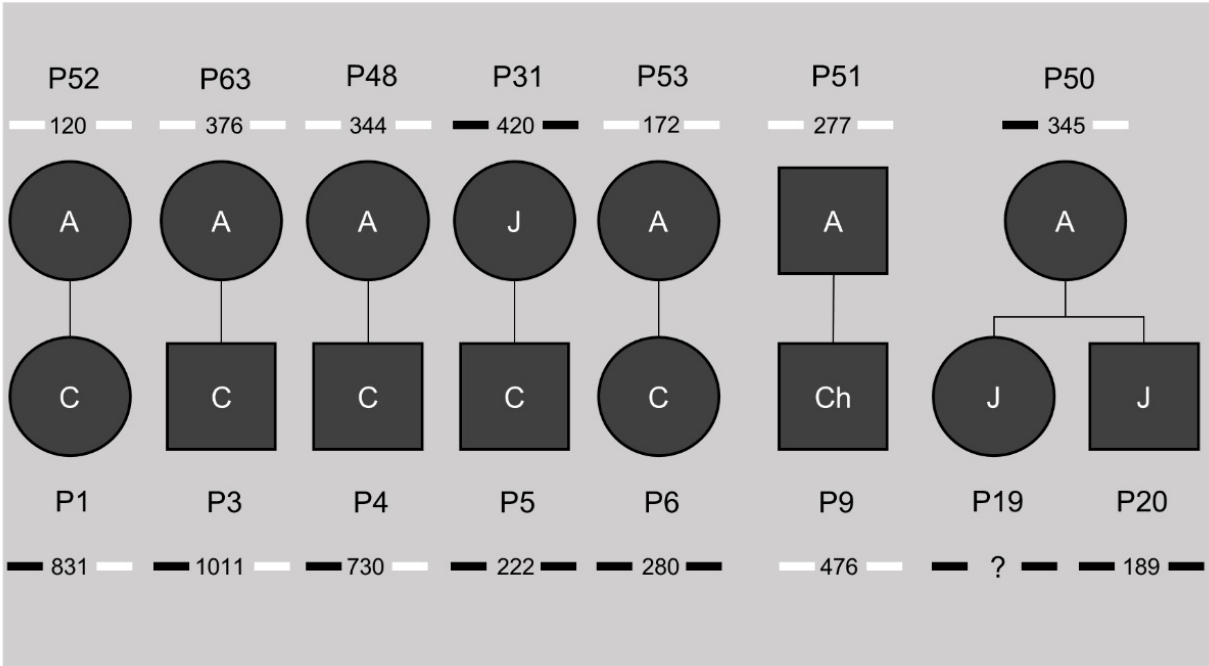
Figure 2. Pedigrees of the known families in our study cohort. The number beneath the patient identification code indicates the ePAL (estimated progenitor allele size), with the bars next to it indicating methylation status of CTCF1 (left) and CTCF2 (right). Black indicates methylation, white no methylation. A = adult, J = juvenile, Ch = childhood, C = congenital. ? = unknown CTG expansion size.